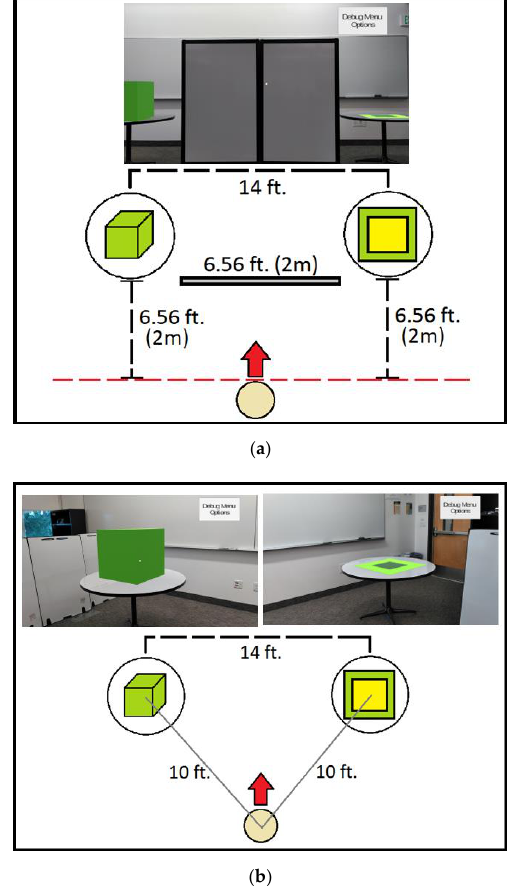
Figure 5. Working with constraints. ( a ) Test 6: view occlusion; ( b ) Test 7: restricted movement.